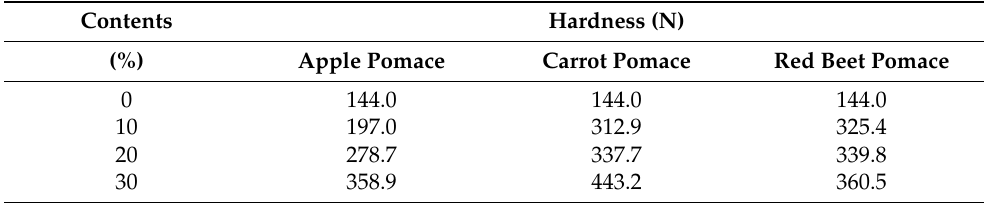
Table 2. Relationship between pellet hardness and the content of pomace addition to the substrate, Lowest Significant Difference (LSD) = 13.85 N, p <